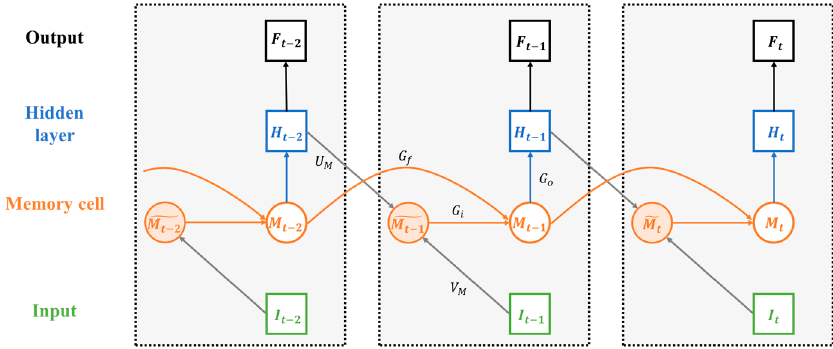
Figure 3. The long short-term memory network.